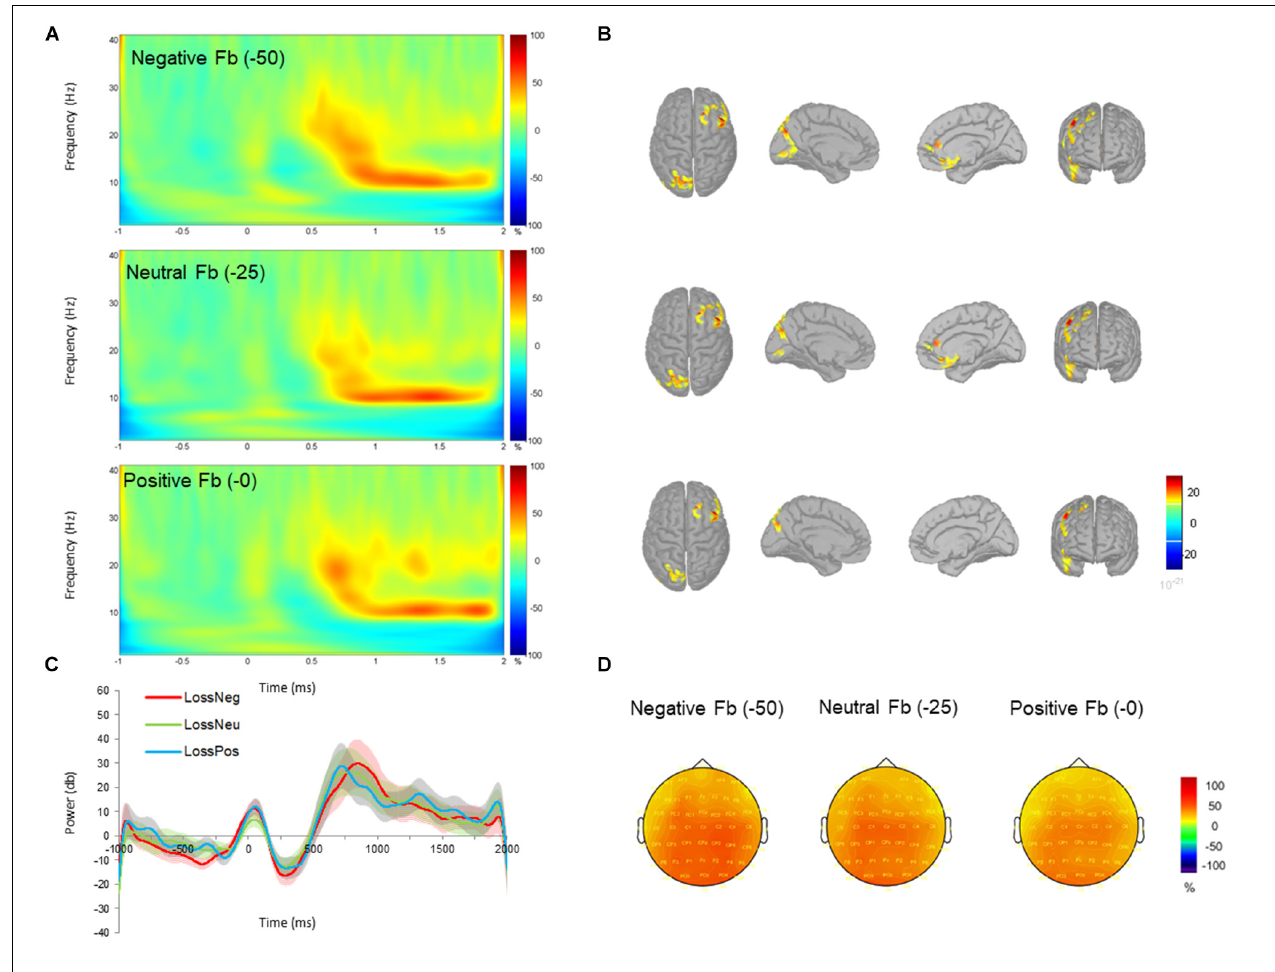
FIGURE 4 | Time-frequency power (total) across negative (–0 MU), neutral (–25 MU) and positive (–50 MU) feedback for loss blocks. (A) Time-frequency plots at channel FCz displaying the changes in power from 700 to 1000 ms with respect to the pre-stimulus baseline (–200 to 0 ms). (B) Beta (12–20 Hz) source activity corresponding to each feedback type displayed for top, left medial, right medial and frontal views. Source activation maps are based on a minimum of 30 vertices with an amplitude threshold value is set to 30%. (C) Time-course of mean beta power with standard error bars in negative (red), neutral (green), and positive (blue) feedback conditions. (D) Scalp topographies plotted at 800 ms post-feedback for 15 Hz.